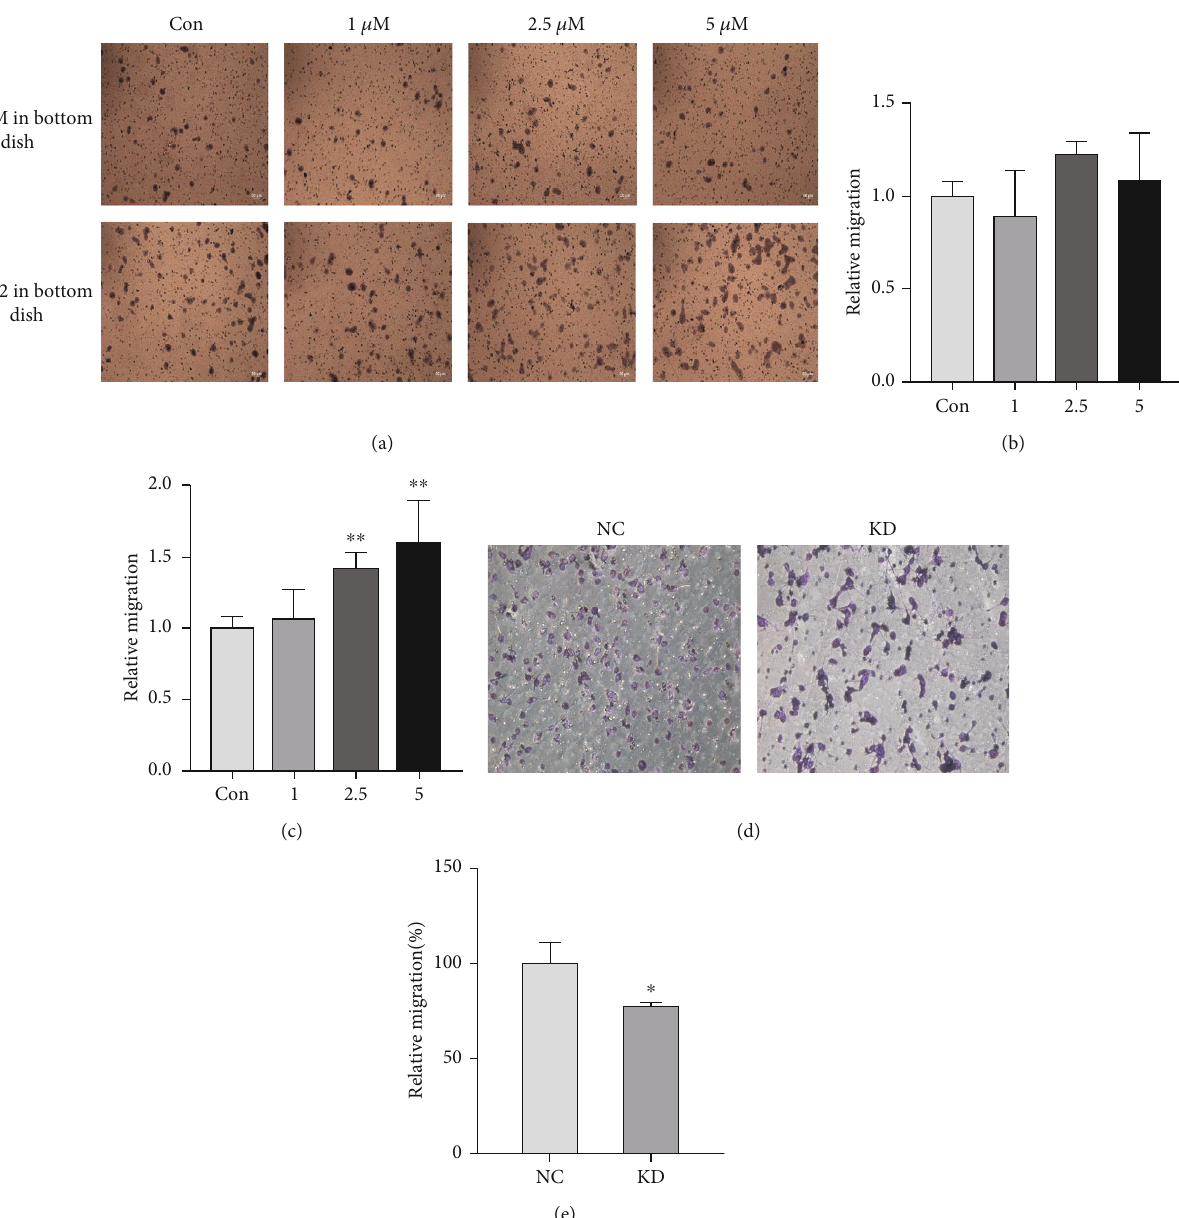
Figure 1: PGRN promotes BV-2 cell migration. (a – c) Di ff erent concentration of A β signi fi cant BV-2 cell migration. (d, e) Knocking down PGRN by siRNA repressed BV-2 cell migration. KD: knock down. ∗ p < 0 : 05 , ∗∗ p < 0 : 01